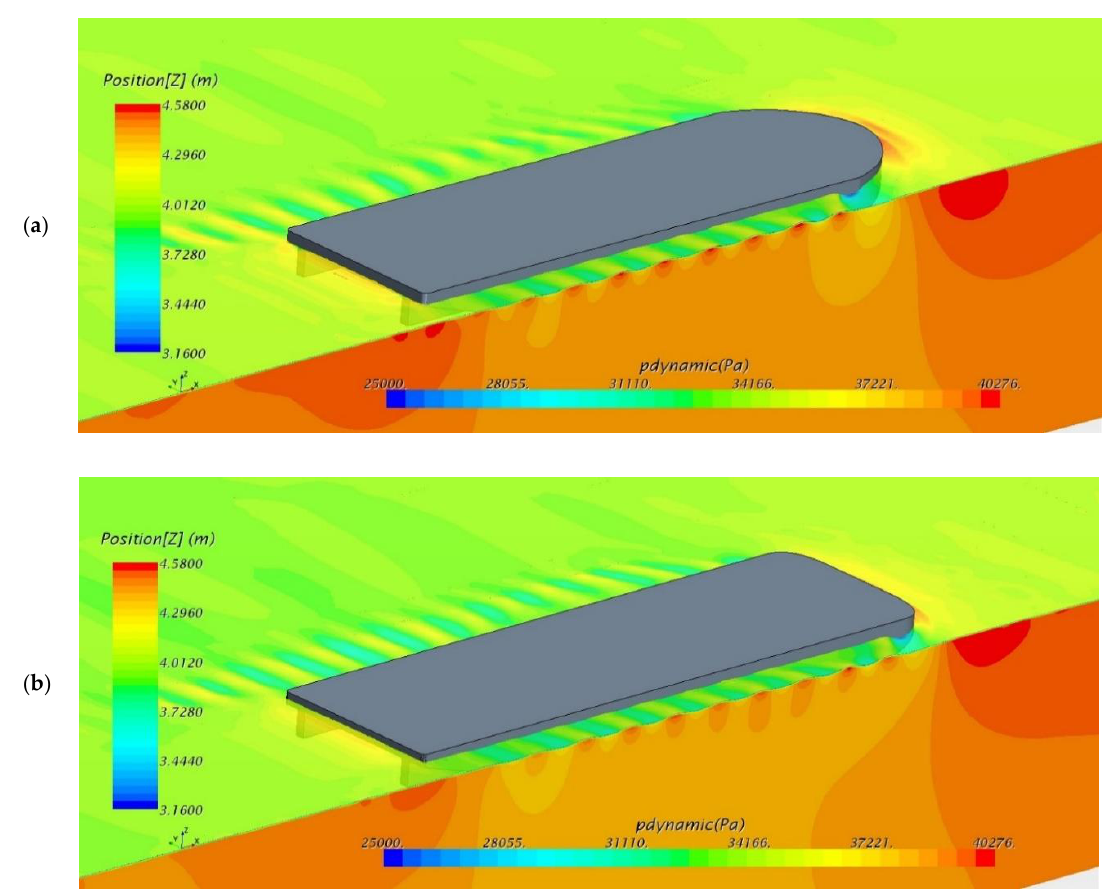
Figure 12. Wave pattern and pressure distribution on bank at y’ = 0.2 B : ( a ) KNU-020; and ( b ) KNU- 030.